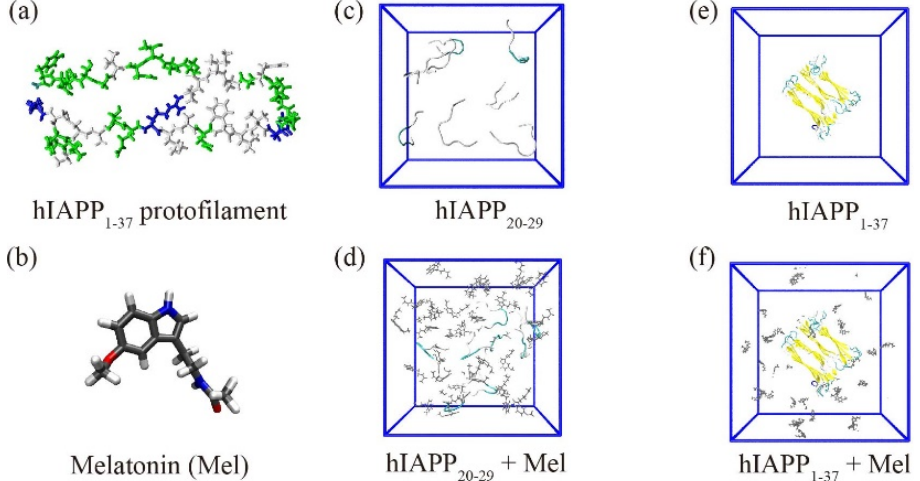
Figure 1. System setup. ( a , b ) The chemical structures of the hIAPP 1–37 protofilament and Mel. ( c – f ) The initial structures of the hIAPP 20–29 octamer and hIAPP 1–37 fibrillar octamer in the absence and presence of Mel.